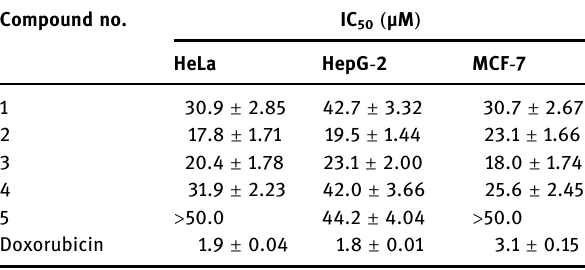
Table 3: Cytotoxic e ff ects of compounds 1 – 5 isolated from Tydemania expeditionis Compound no.